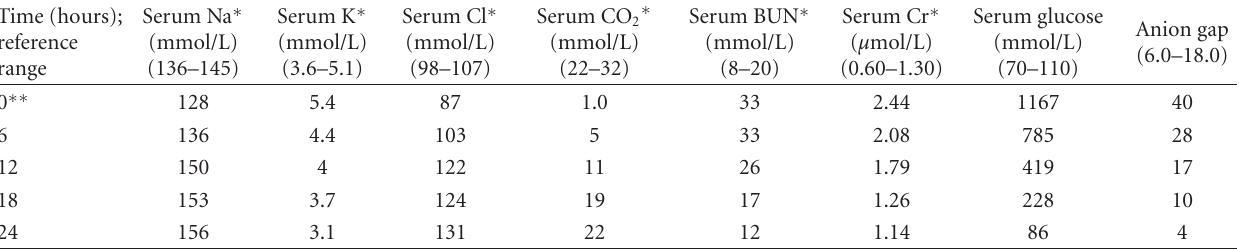
Table 1: Admission and follow-up metabolic profile after appropriate treatment with intravenous saline and insulin. Time